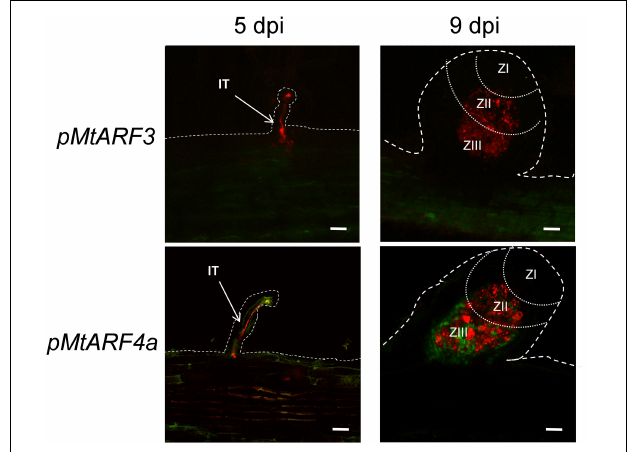
FIGURE 2 | Promoter:reporter fusion expression analysis of MtARF3 and MtARF4a at different stages of the symbiotic interaction with S. meliloti. GFP fluorescence was analyzed in roots transformed with the pMtARF3:GUS-GFP (upper panels) or the pMtARF4a:GUS-GFP (bottom panels) construct at 5 days post-inoculation (dpi) and in developing nodules at 9 dpi with a strain of S. meliloti that expressed the red fluorescent protein (RFP). Dashed lines mark the epidermal cells of roots and nodules. Dotted lines separate different nodule zones. ZI, meristematic zone; ZII, infection zone; ZIII, fixation zone; IT, infection thread. Bars = 50 µ